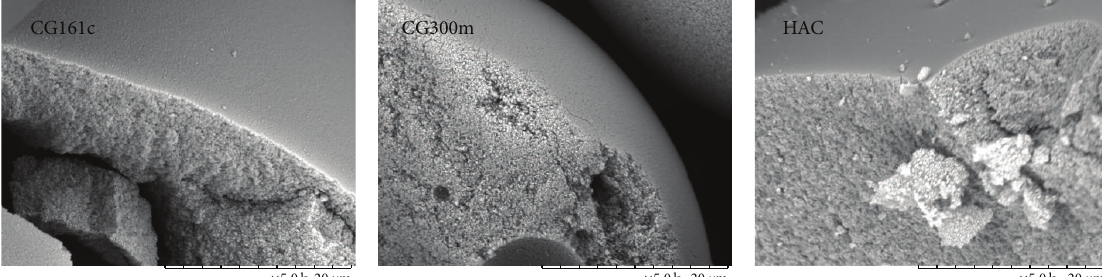
Figure 2: Imaging and particle size of the used adsorbents. SEM images at 5000x magnification and particle size distribution using laser-light scattering of the three tested adsorbents.